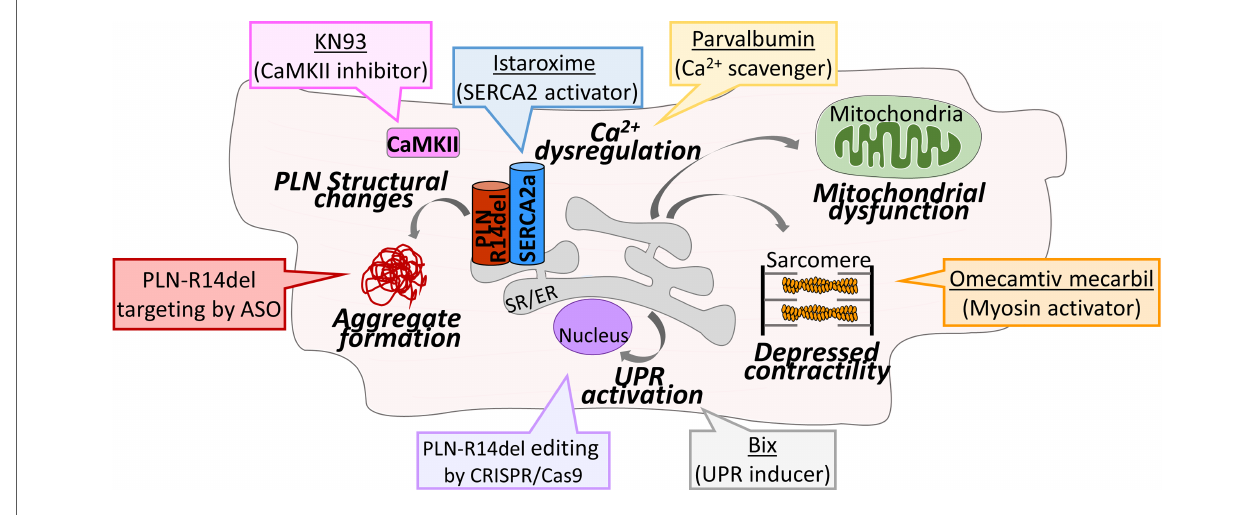
FIGURE 2 Key pathological mechanisms underlying PLN-R14del and promising strategies for therapeutic interventions. Diagrammatic overview of aberrant molecular mechanisms contributing to PLN-R14del disease pathophysiology, that are currently under investigation as promising targets by different therapeutic approaches (colored